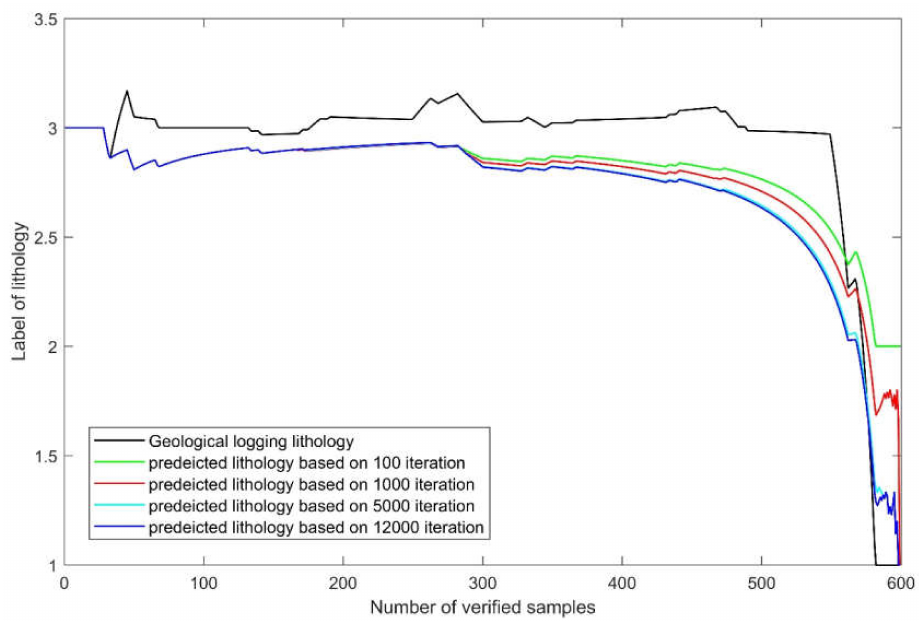
Figure 11. Comparison of the predicted lithology of tested samples under different iterations.